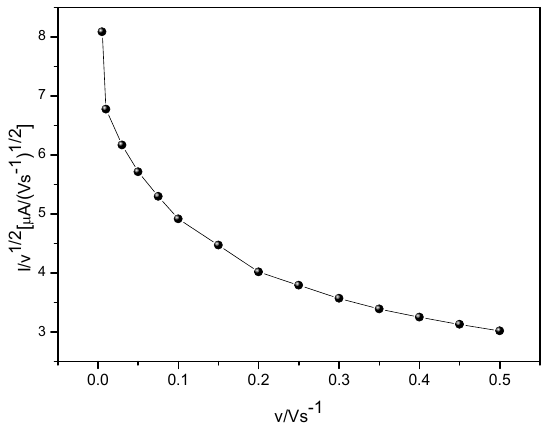
Figure 5. Relationship between current function (Ipa/v 1/2 ) versus scan rate for 175 μmol L −1 of Ethinyl estradiol in solution 0.10 mol L −1 phosphate buffer, pH 7.0; using GCE-MWCNT-CoPc.